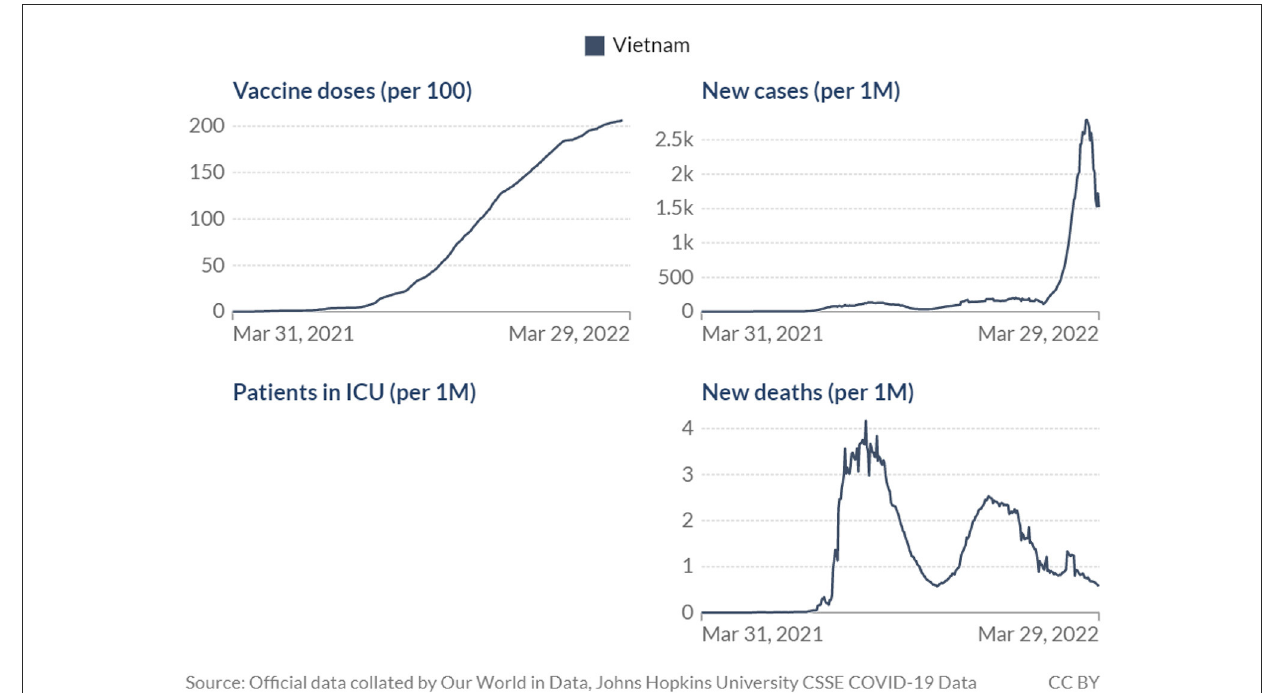
FIGURE1 COVID-19 vaccine doses, ICU patients, and confirmed